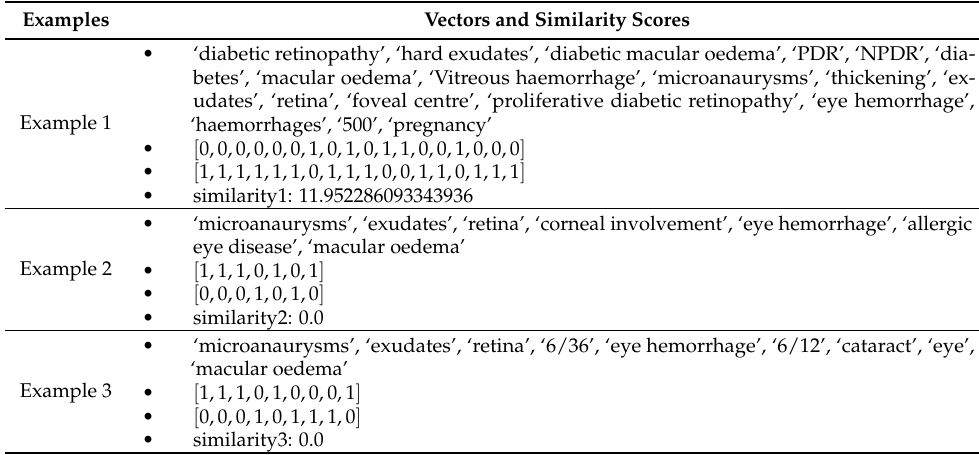
Table 4. Matching of referral’s medical vectors to several CPC condition